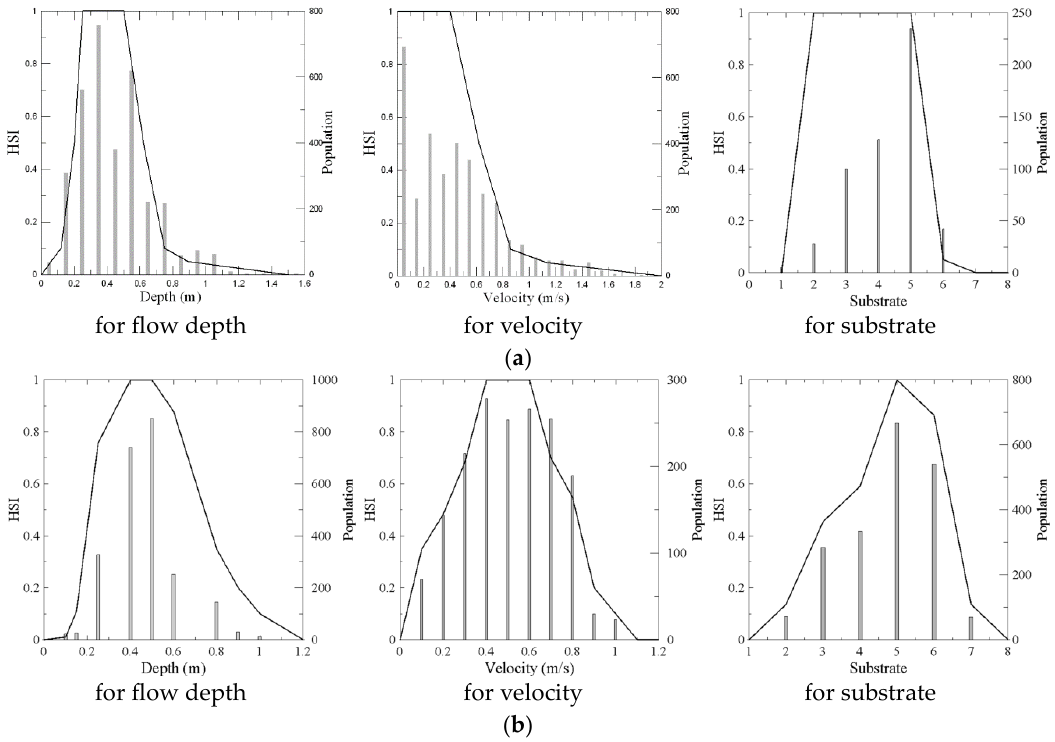
Figure 4. The habitat suitability curves for the target species: ( a ) Zacco platypus and ( b ) Baetis fuscatus .